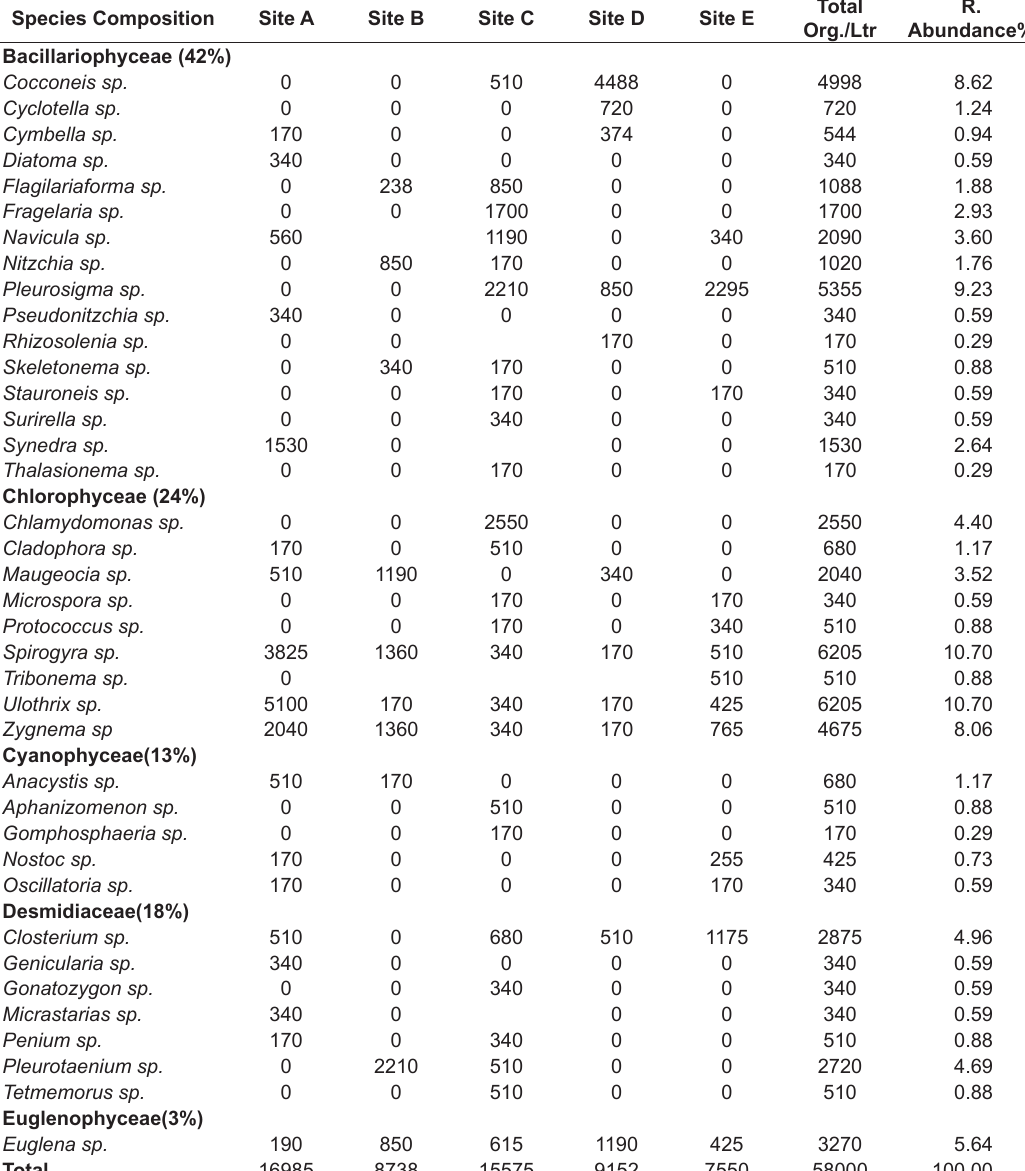
Table 1. Species composition and relative abundance of the phytoplankton from five the sampling sites at Nasarawa reservoir during the study